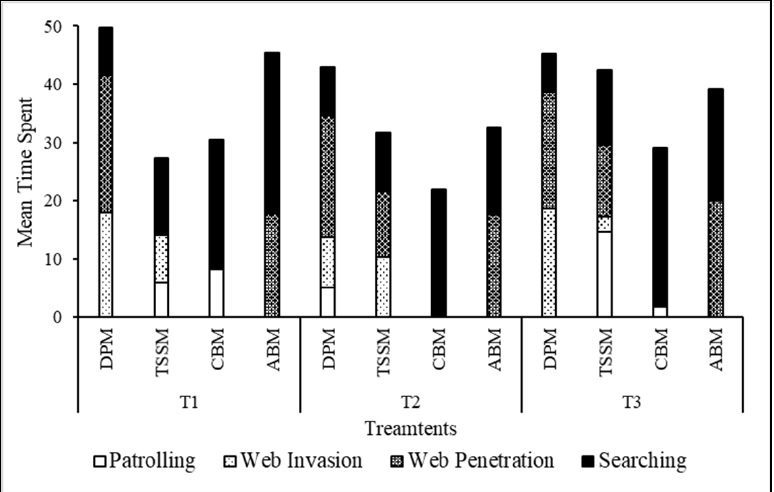
Figure 4. Mean time (min) spent in different attack behaviors by female Stethorus gilvifrons against webbing structures of date palm mite (DPM) O. afrasiaticus , two-spotted spider mite (TSSM) T. urticae , citrus brown mite (CBM) E. orientalis and avocado brown mite (ABM) O. punicae